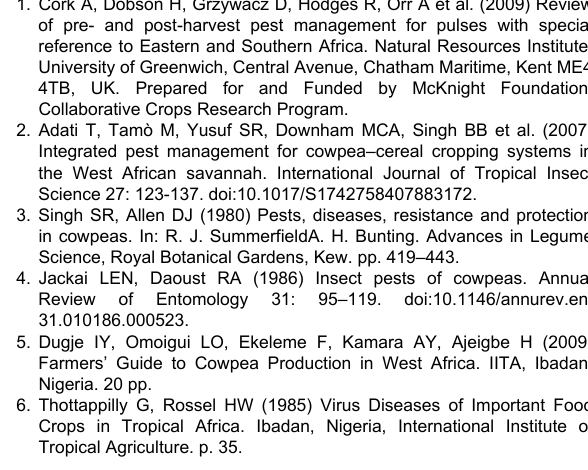
Table S3. a. Summary of all SNPs detected in contigs in A. curvipes , including sequence description, length, organism, minimum e-value, number of GOs and number of SNPs associated with each contig. b. Summary of all SNPs detected in contigs in A. craccivora , including sequence description, length, organism, minimum e-value, number of GOs and number of SNPs associated with each contig. c. Summary of